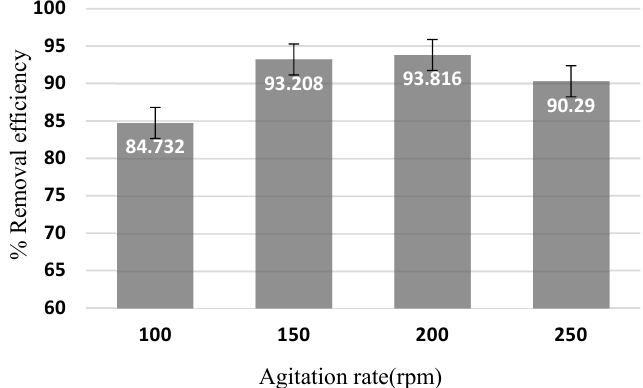
Figure 7. E ff ect of agitation rate variation on arsenic removal e ffi ciency (initial arsenic concentration: Figure 7. Effect of agitation rate variation on arsenic removal efficiency (initial arsenic concentration: 0.075 g / L, sorbent dosage: 2 g / L, contact time: 20 min, pH = 0.075 g/L, sorbent dosage: 2 g/L, contact time: 20 min, pH = 6).